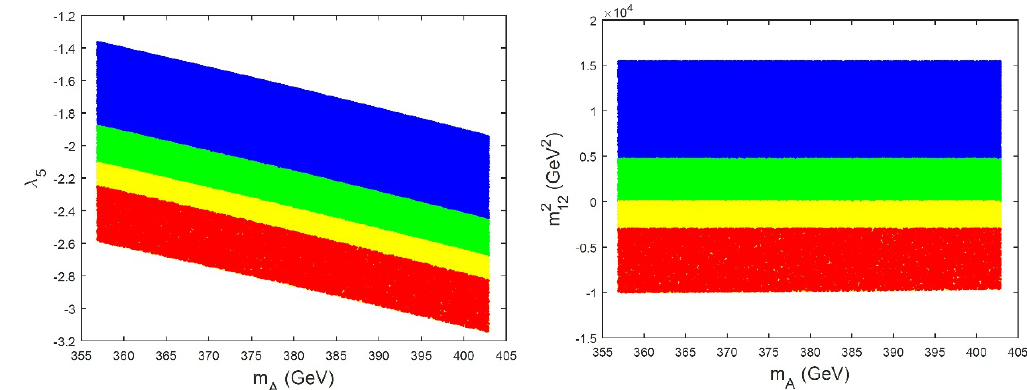
Figure 7 . Scatter plots of (cid:21) 5 (left) and m 2 in section 6.3. The colour code is the same as in (cid:12)gure